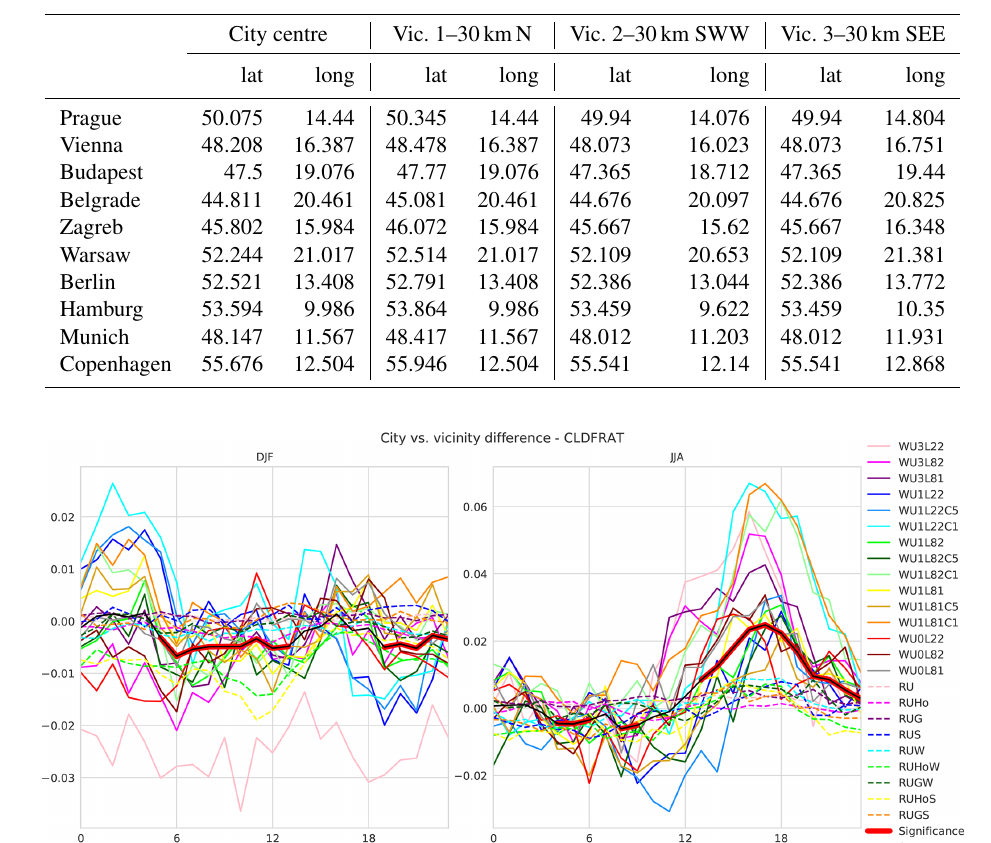
Table 4. Positions of city centres and vicinities (vic.) for chosen cities.